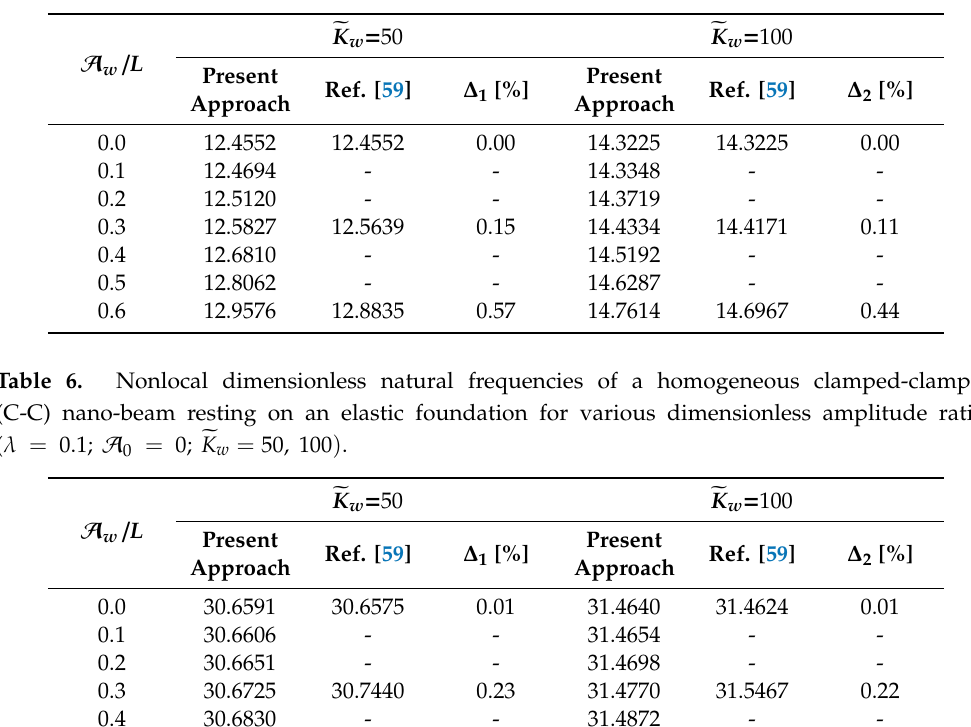
Table 5. Nonlocal dimensionless natural frequencies of a homogeneous simply-supported (S-S) nano-beam resting on an elastic foundation for various dimensionless amplitude ratios